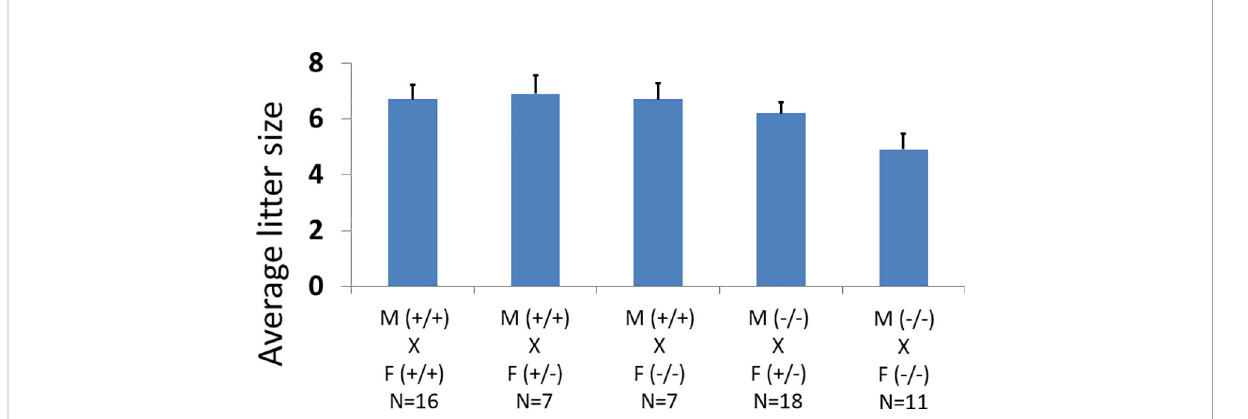
FIGURE 2 Effects of oocyte-speci fi c Adm2 disruption on the fecundity offemale mice. The average litter size of wild-type ( Adm2 ++ / Zp3 -Cre), heterozygous ( Adm2 +/- / Zp3 -Cre), and homozygous ( Adm2 -/- /Zp3 -Cre) mice are represented by vertical bars (mean ± SEM). The crosses included those between wild-type males (M, +/+), and wild-type (F, +/+, N=16), heterozygous (F, +/-, N=7) or homozygous (F, -/-, N=7) females as well as those between homozygous males (M, -/-), and heterozygous (F, +/-, N=18) or homozygous (F, -/-, N=11) females. The litter size ranged from 4.9 ± 0.56 in crosses between homozygous males and homozygous females to 6.9 ± 0.67 in crosses between wild-type males and heterozygous